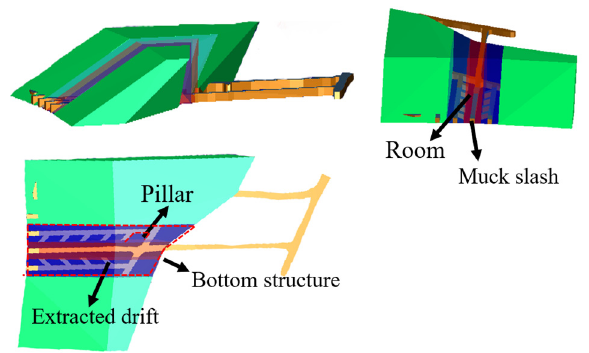
Figure 1. Stope solid model.